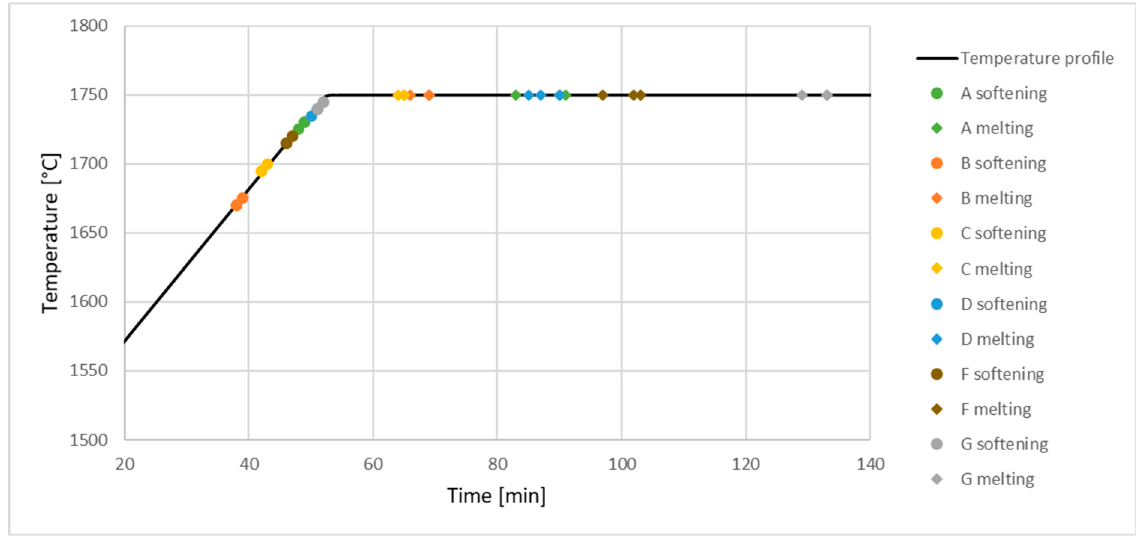
Figure 2. Softening and melting temperature for quartz type A, B, C, D, F and G.